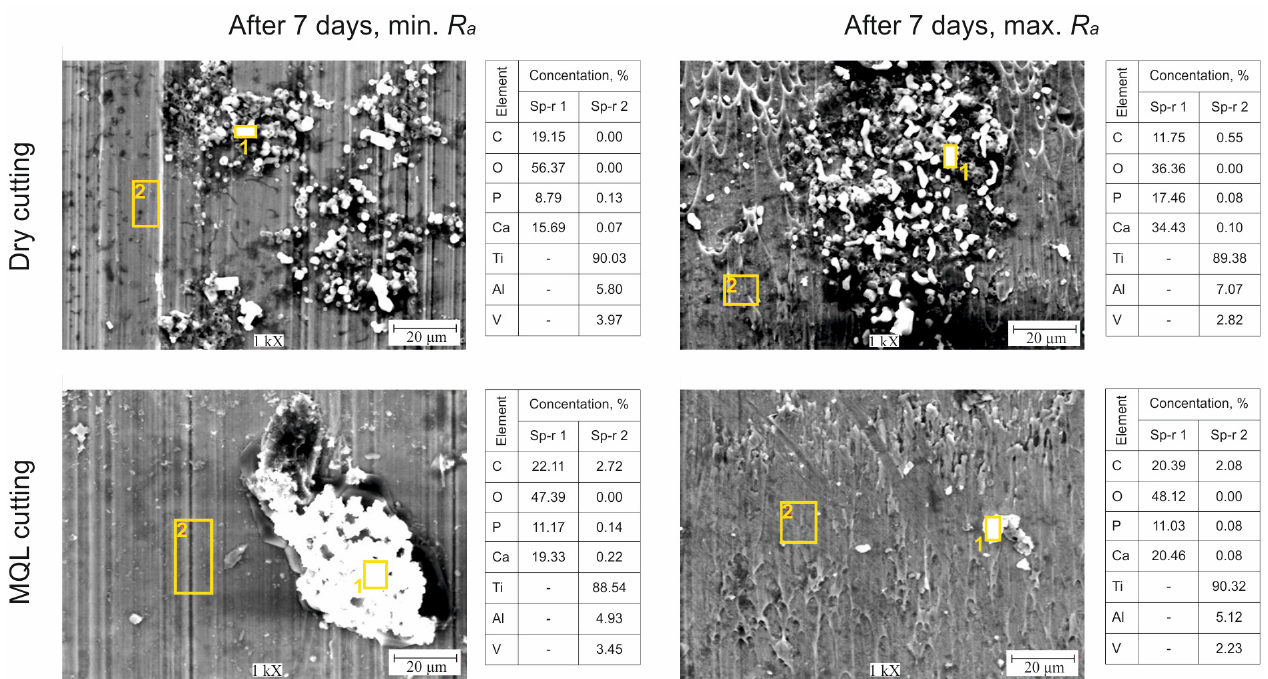
Figure 5. SEM pictures and EDS analysis results for Ti6Al4V alloy with R amin and R a max under dry and MQL conditions after 7 days of storage in SBF.